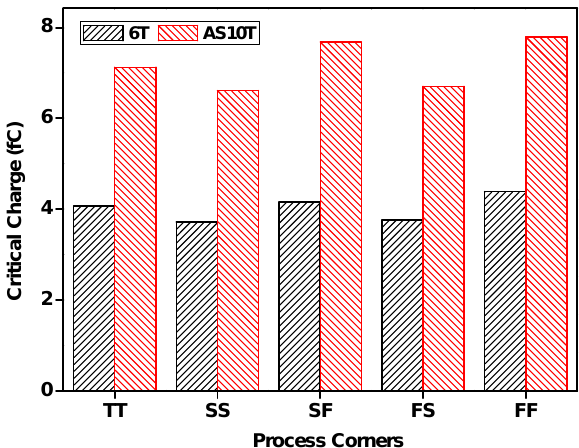
Figure 10. Critical charge at the sensitive node of SRAM cells for different process corners.